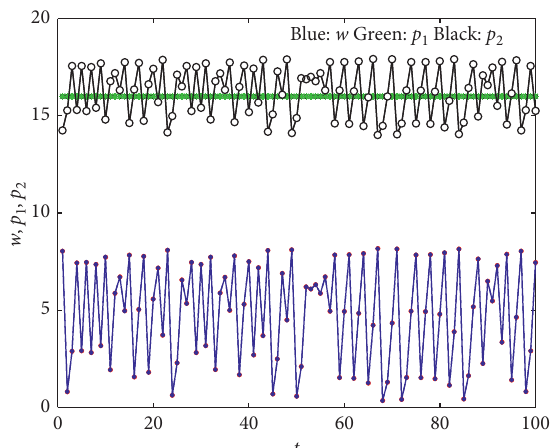
Figure 24: Time series of w, p